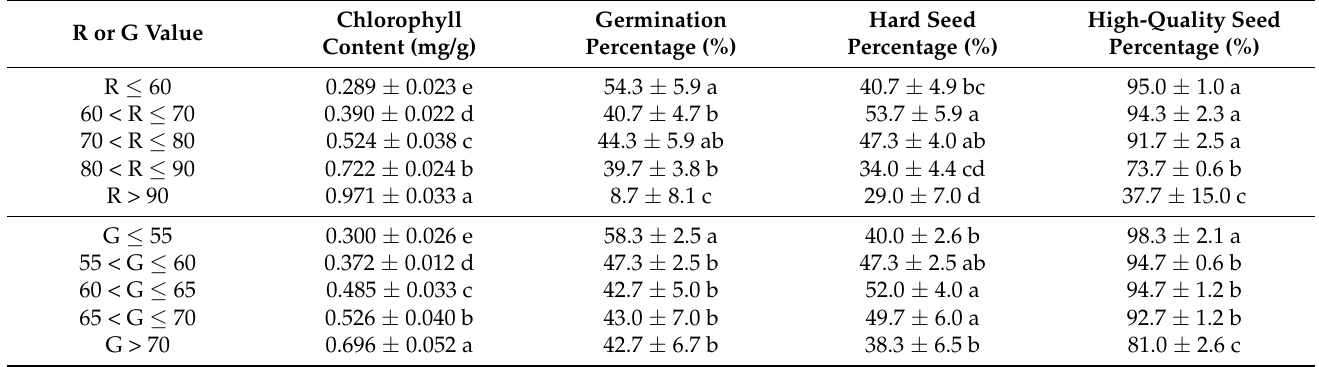
Table 4. Statistics of germination percentage and hard seed percentage of Astragalus seeds in different R and G value groups.